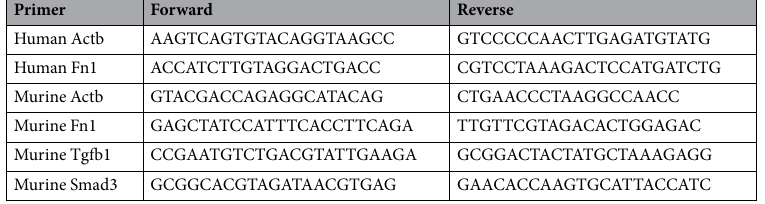
Table 1. Primers utilized for